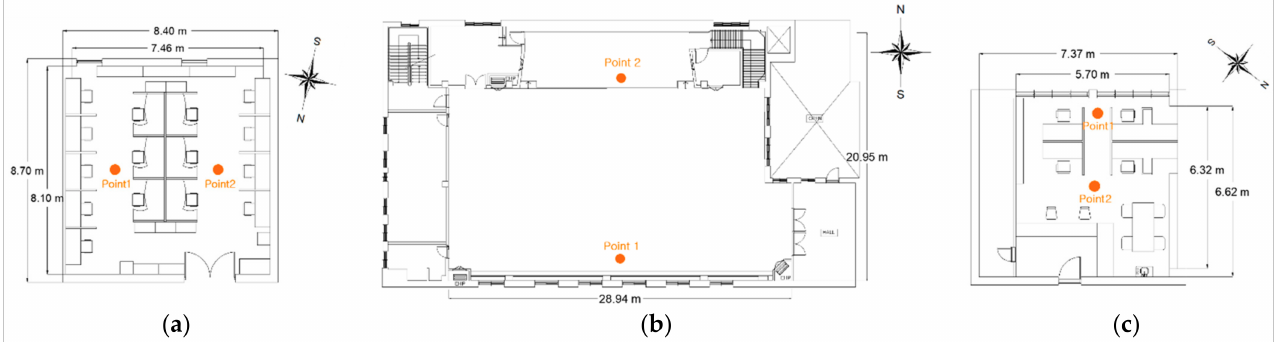
Figure 4. Indoor air quality measurement site drawing: ( a ) a 60.4 m 2 office space, ( b ) a 616.1 m 2 multipurpose activity space, and ( c ) a 48.7 m 2 office space.